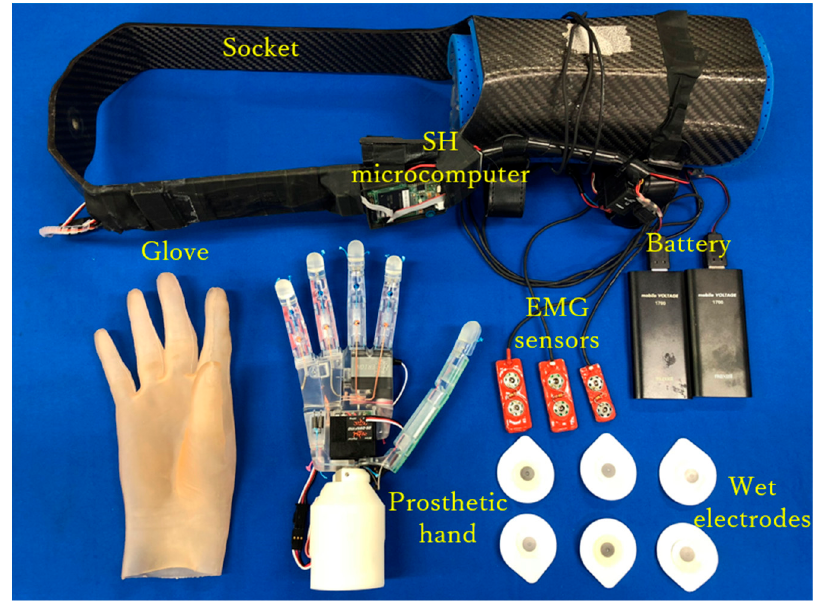
Figure 16. Experimental devices.